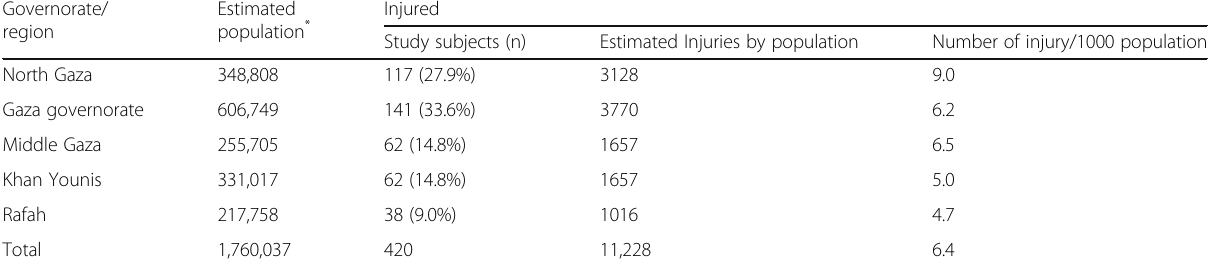
Table 2 Proportion and number of injuries per 1000 population (n = 420, N = 11,228) Governorate/ region